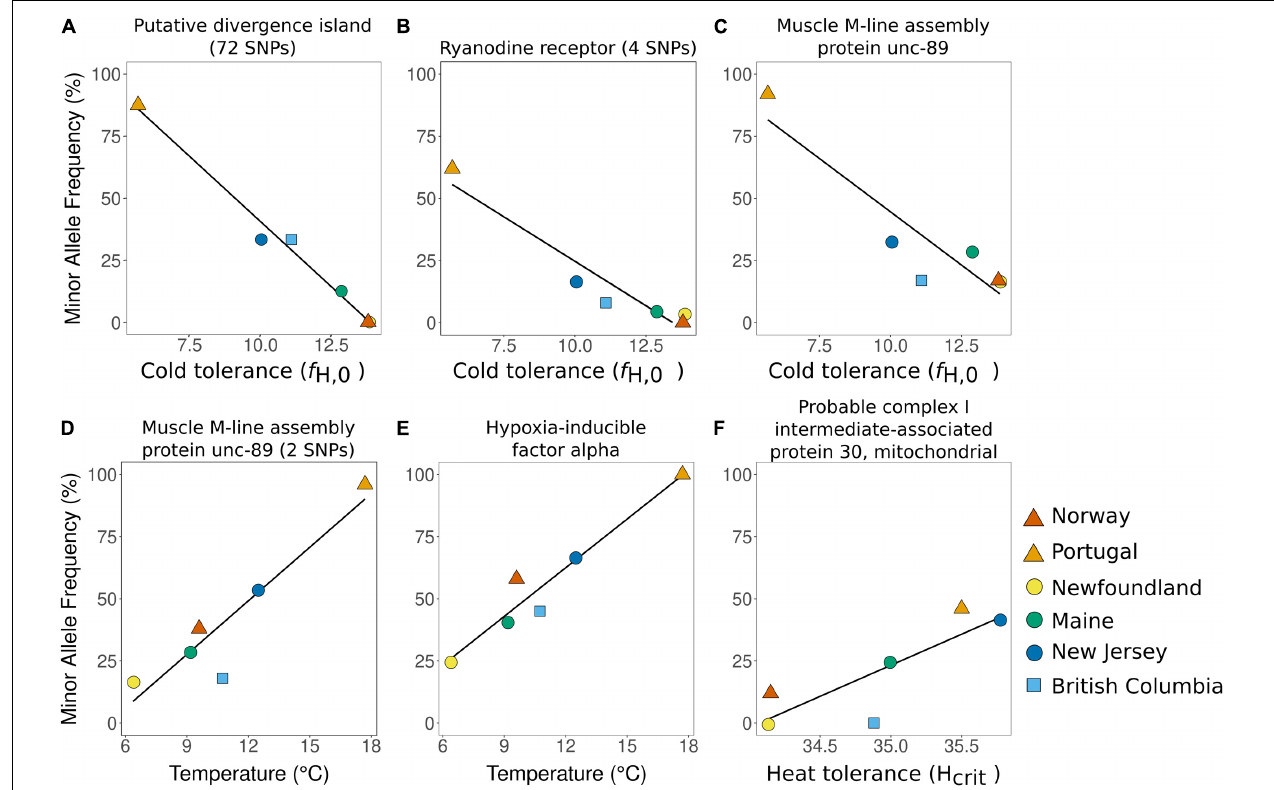
FIGURE 4 | (A–F): Relationship between minor allele frequency and temperature or physiology at top candidates for ongoing selection. Each panel shows the linear relationship between minor allele frequency and population-level cold or heat tolerance or mean sea surface temperature. For (A) , allele frequency was calculated over all 72 SNPs based on the first principal component in Figure 3C . For (B,D) , points are shown for one representative SNP; all SNPs in these contigs are in strong LD and differences among them are negligible. For (C,E,F) , plots show a single outlier